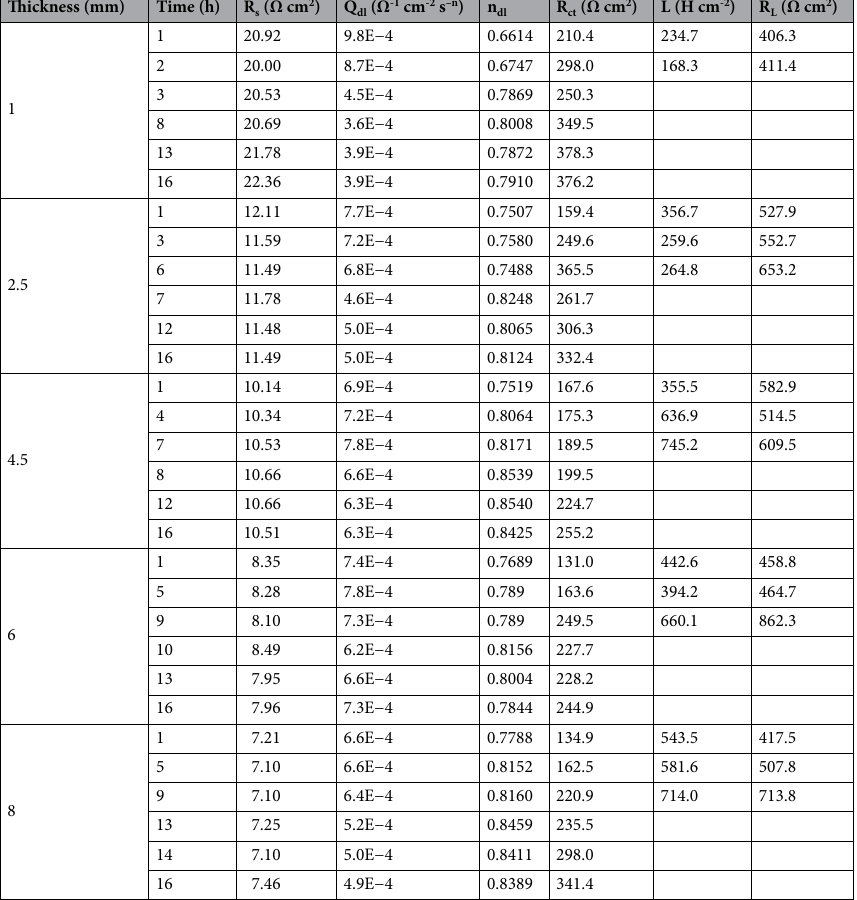
Table 2. Equivalent circuit fitting data of EIS data of samples with ADP under static liquid film.